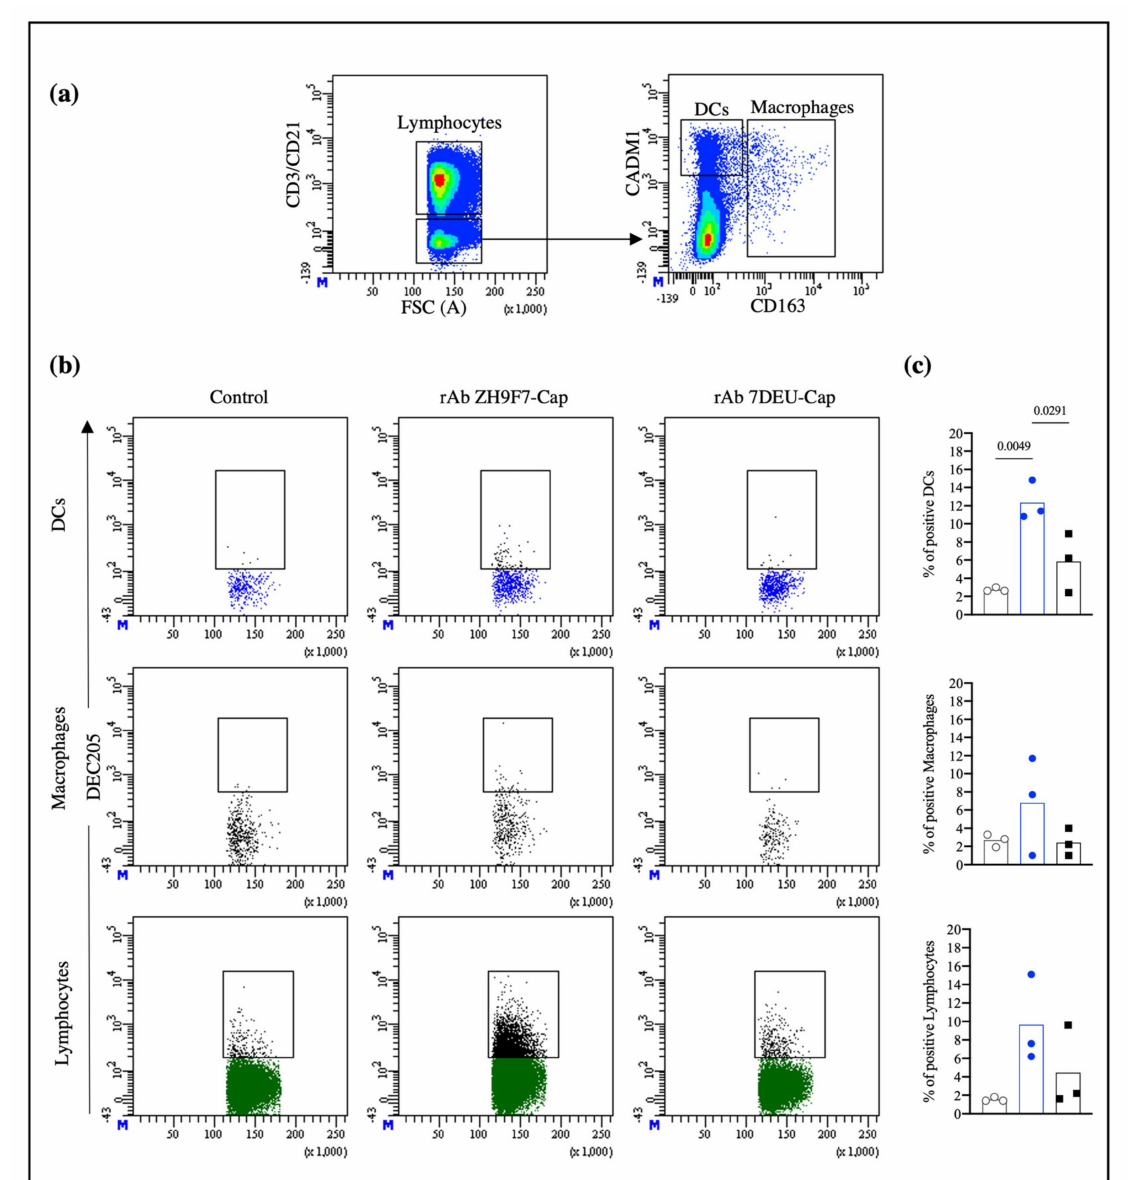
Figure 5. Targeted skin DCs and lymphocytes migrate to regional inguinal nodes. ( a ) Strategy to analyze DEC205 + -targeted cells in superficial inguinal lymph nodes. The CD3 − CD21 − population was analyzed for CD163 and CADM1 expression (bottom panel) and to identify potential DCs (CD3 − CD21 − CADM1 + CD163 − ). ( b ) Analysis of rAb targeted DEC205 + cells from the control, rAb ZH9F7-Cap, and rAb 7DEU-Cap. ( c ) Average percentages of DCs and macrophages. PBS control (gray); rAb ZH9F7-Cap (blue); Isotype control rAb 7DEU-Cap (black). One-way ANOVA and the Tukey–Kramer test for multiple comparisons of means were performed ( p < 0.05). p -values